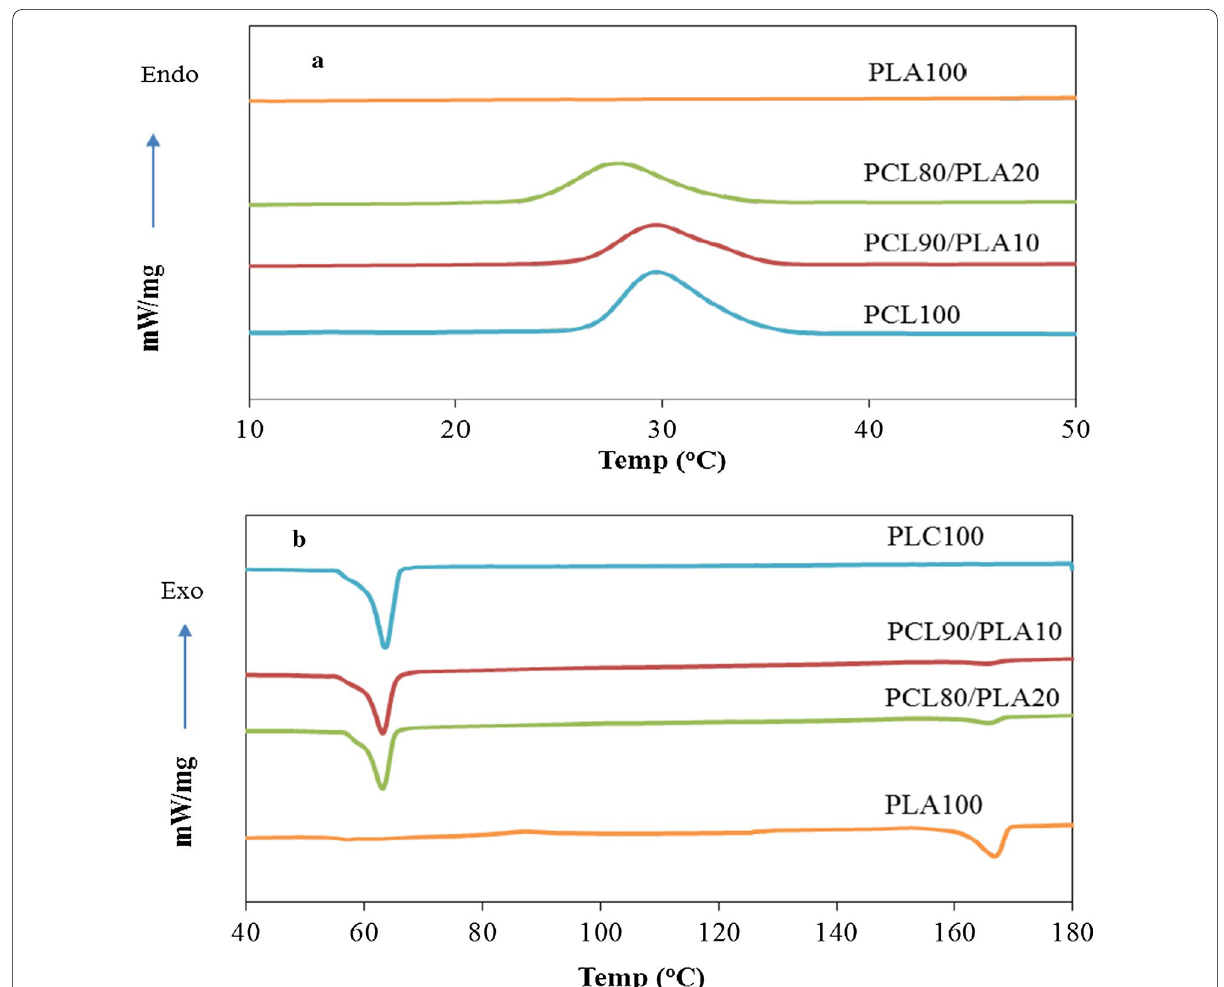
Table 4 DSC Results for PCL, PLA and their blends